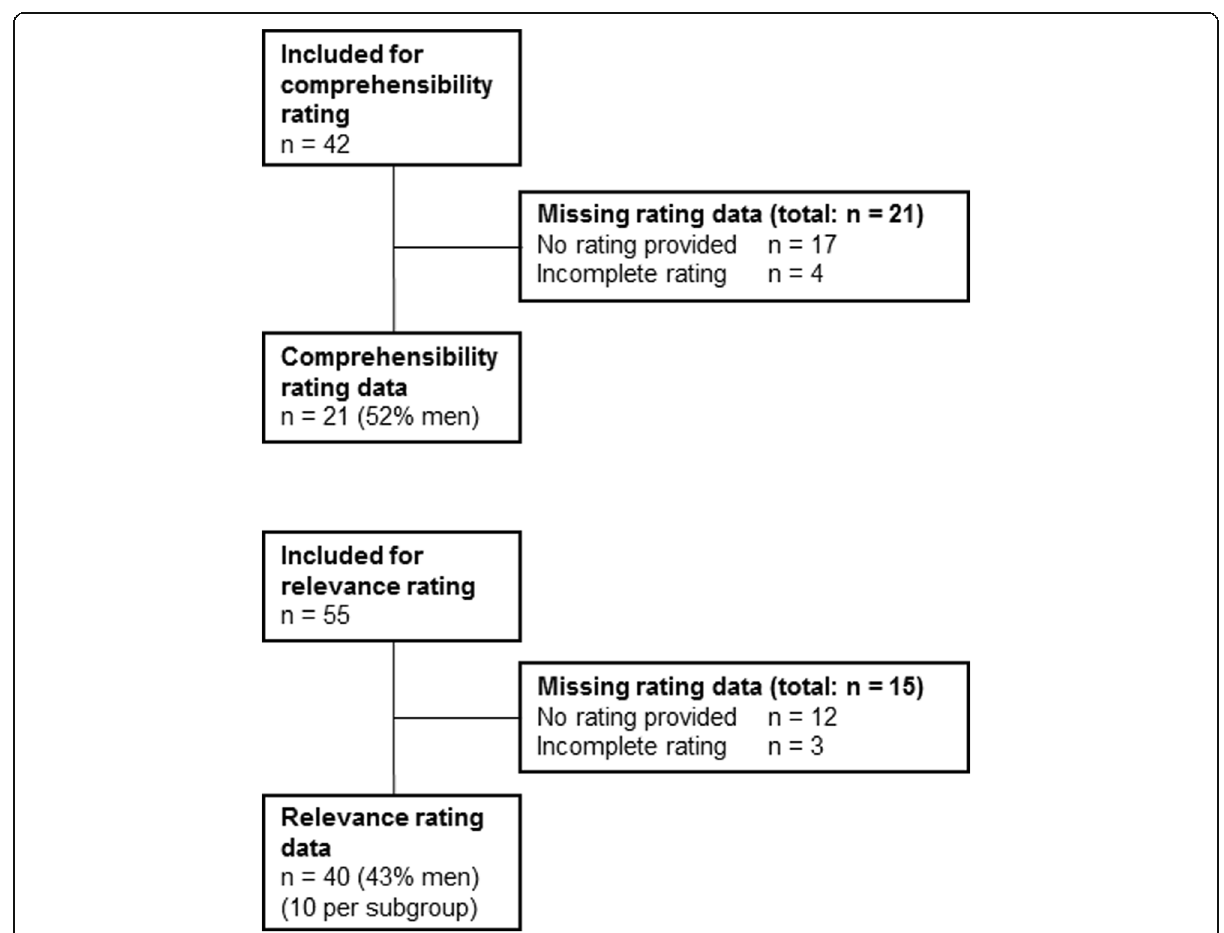
Fig. 1 Flow chart of the patient subgroup assessment of German IKDC-SKF item comprehensibility and